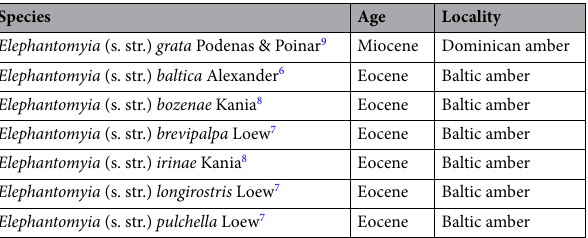
Table 1. List of fossil species belonging to the genus Elephantomyia described before the present study, with age and localities.